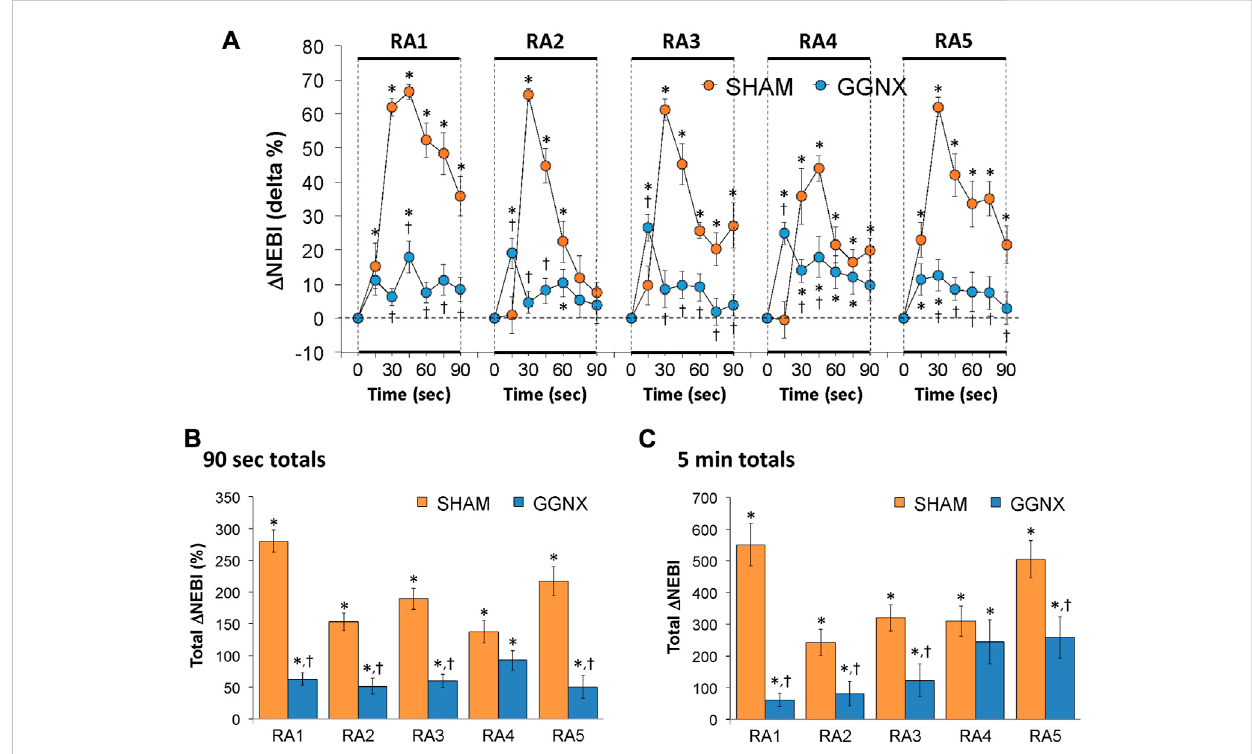
FIGURE 15 (A) Arithmetic changes in non-eupneic breathing index (NEBI) from Pre-values in sham-operated (SHAM) rats and in rats with bilateral ganglioglomerular nerve transection (GGNX) during the fi rst 90 s upon return to room-air (RA1-RA5), following the 5 hypoxic (HX, 10% O 2 , 90% N 2 ) gas challenges. (B) Total arithmetic changes in NEBI during the fi rst 90 s of the return to room-air phases (RA1-RA5). (C) Total arithmetic changes in NEBI during the fi rst5 min ofthereturnto room-airphases(RA1-RA5).TheSHAMgroup had10rats. TheGGNX grouphad 12rats. Thedata